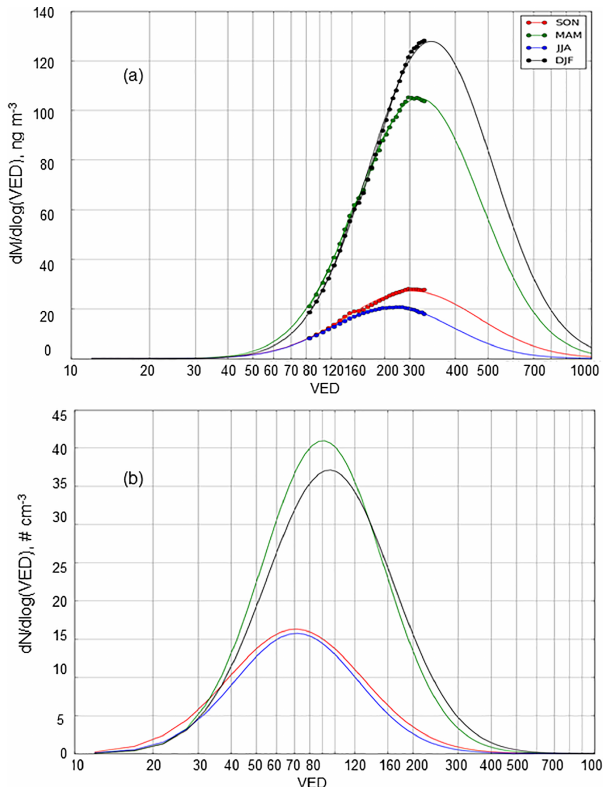
Figure 3. Seasonally averaged mass (a) and number (b) distribu- tions, by volume equivalent diameter (VED), of rBC particles de- tected by the SP2 in Alert, NU, from March 2011 to December 2013. The number distributions are estimated from the fits to the mass distribution. The black, green, blue, and red data curves rep- resent the 3-month average season: winter (DJF), spring (MAM), summer (JJA), and fall (SON), respectively. On average, a modal mass diameter at 225nm was measured for rBC during winter and around 170nm during summer. The number distribution shows a mode at 100nm during winter due to long-range transport influence and during the light period in the spring, giving a smaller particle diameter. VED indicates volume equivalent diameter. The solid cir- cles represent the size range of calibration.